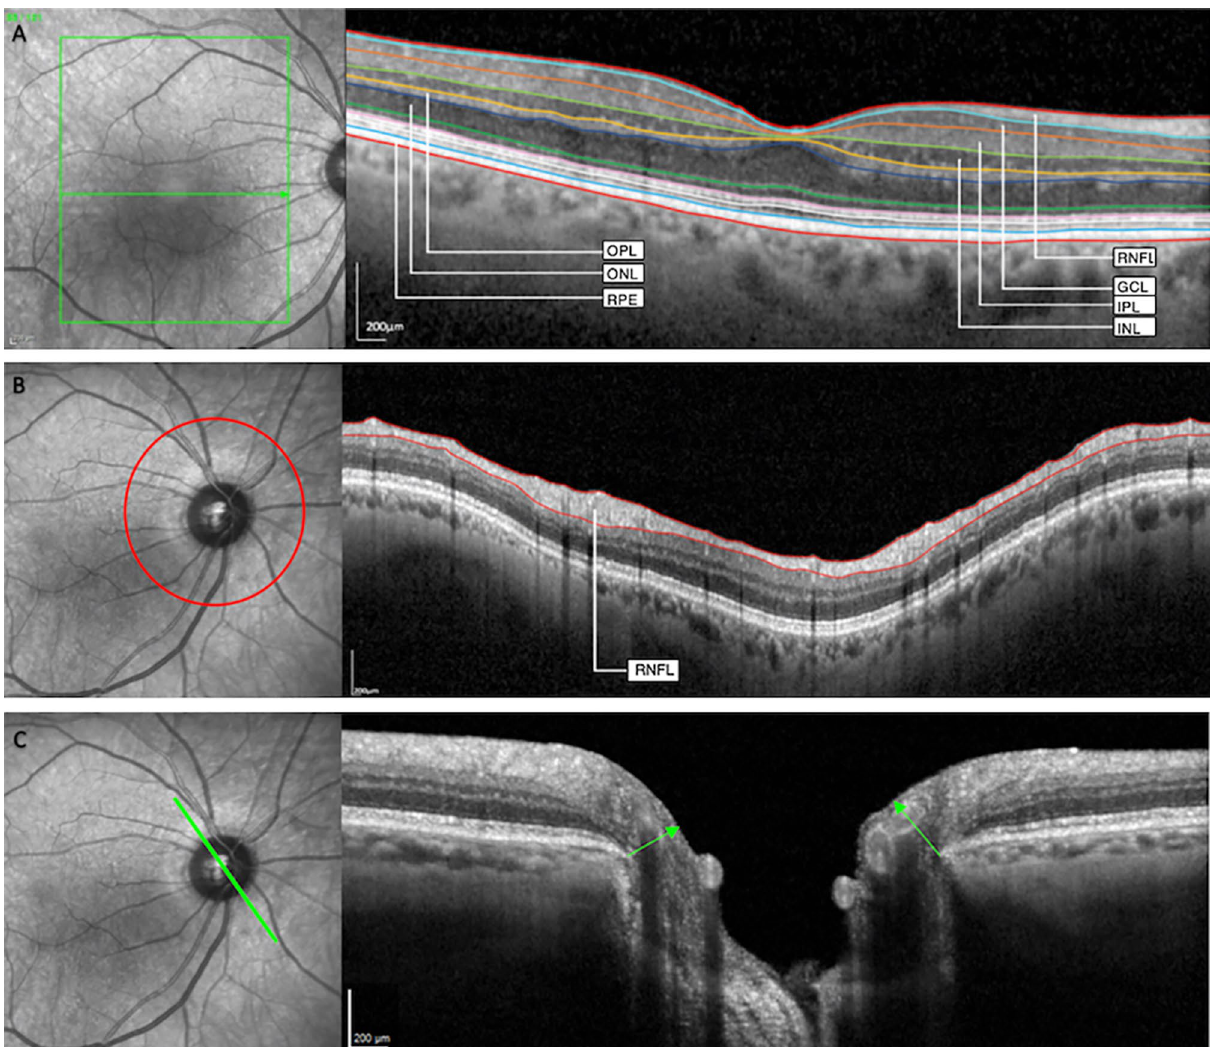
Figure 2. Optical coherence tomography-images of 75-year old participant. ( A ) Macular scan—different macular layers are segmented; ( B ) RNFL-scan—the peripapillary retinal nerve fiber layer (pRNFL) is segmented; ( C ) BMO-scan—the arrows show the Bruch’s membrane opening-minimum rim width (MRW). RNFL retinal nerve fiber layer, GCL ganglion cell layer, IPL inner plexiform layer, INL inner nuclear layer, OPL outer plexiform layer, ONL outer nuclear layer, RPE retinal pigment